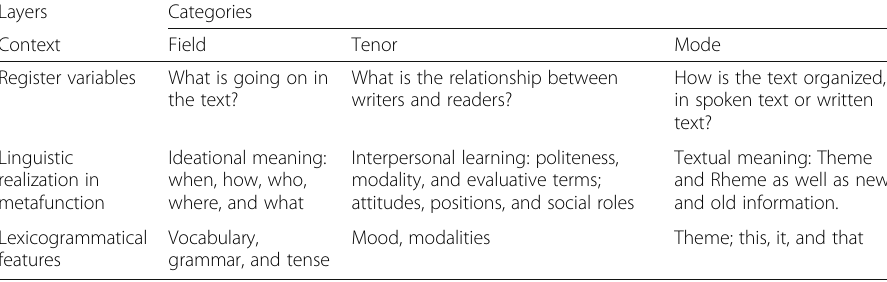
Table 1 Context of the Situation and Linguistic Features